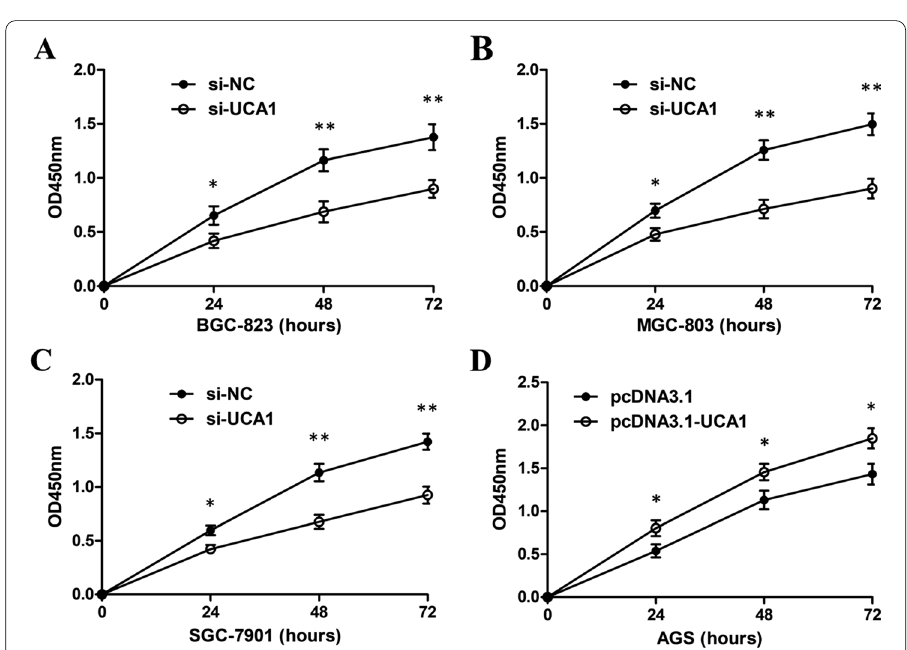
Fig. 3 UCA1 promotes GC cell proliferation in vitro. A CCK-8 experiment indicated that UCA1 knockdown inhibited cell proliferation of BGC-823 cells. B CCK-8 assay revealed that UCA1 knockdown inhibited MGC-803 cell proliferation. C CCK-8 assay showed that UCA1 knockdown inhibited SGC-7901 cell proliferation. D CK-8 assay showed that UCA1 overexpression promoted AGS cell proliferation. *p < 0.05, **p < 0.01, compared